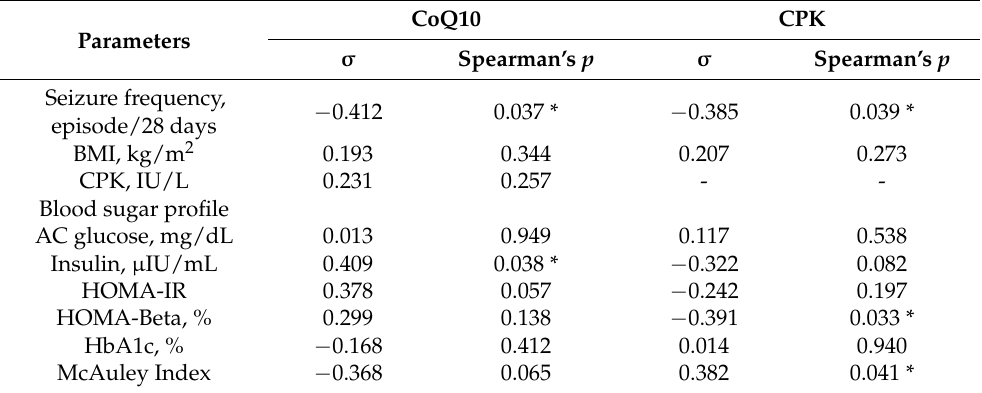
Table 2. The correlation between serum CoQ10 level, CPK level and other characteristics of AED- resistant epilepsy patients.